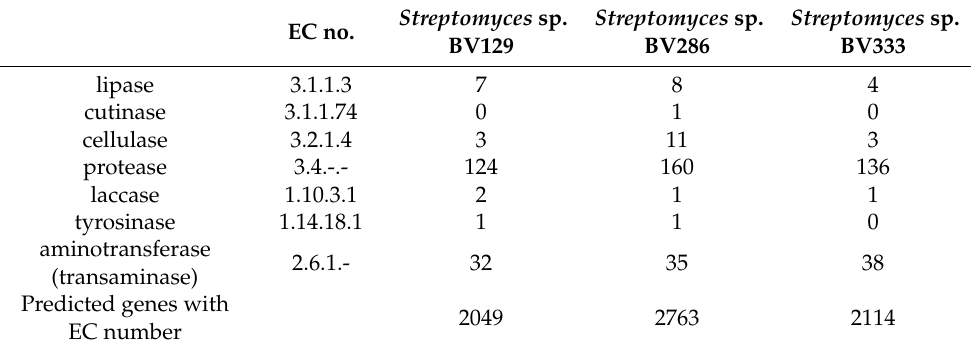
Table 2. Prokka-based prediction of selected genes in the de novo assembled genomes of Streptomyces sp. BV129, BV333 and BV286. Enzymes potentially acting in the degradation of different substrates are shown together with the corresponding EC category, other categories for which no genes were predicted by Prokka are not shown. Streptomyces sp. Streptomyces sp. Streptomyces sp. EC no. BV129 BV286 BV333